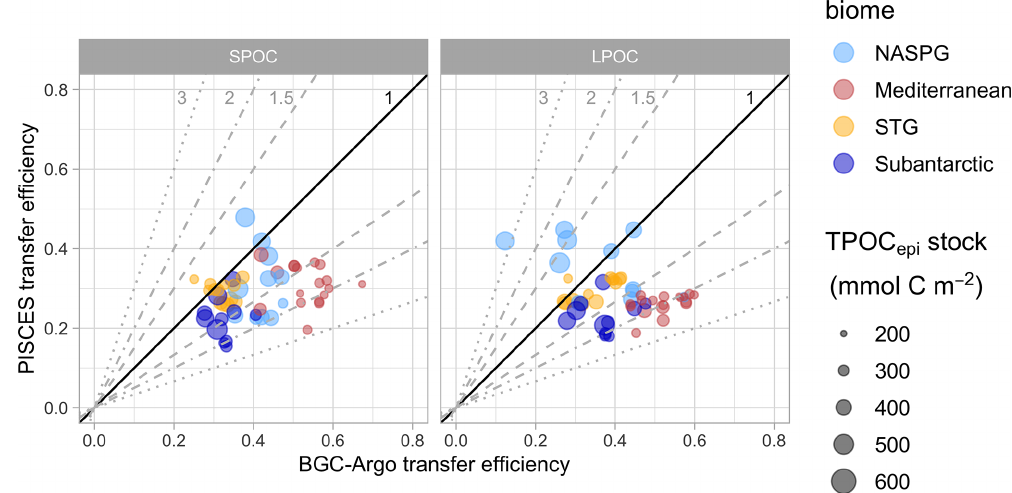
Figure 10. Mean annual POC transfer efficiency between 200 and 700m. BGC-Argo versus PISCES scatterplots are shown for small POC (SPOC) and large POC (LPOC). Reference lines indicate a range of model / data ratios, from 1 : 1 (perfect correspondence) to a factor of 3 or its inverse. Biomes are distinguished with different colors, and the size of the circles is proportional to the annual mean TPOC stock in the epipelagic layer (0–200m), used as an indicator of